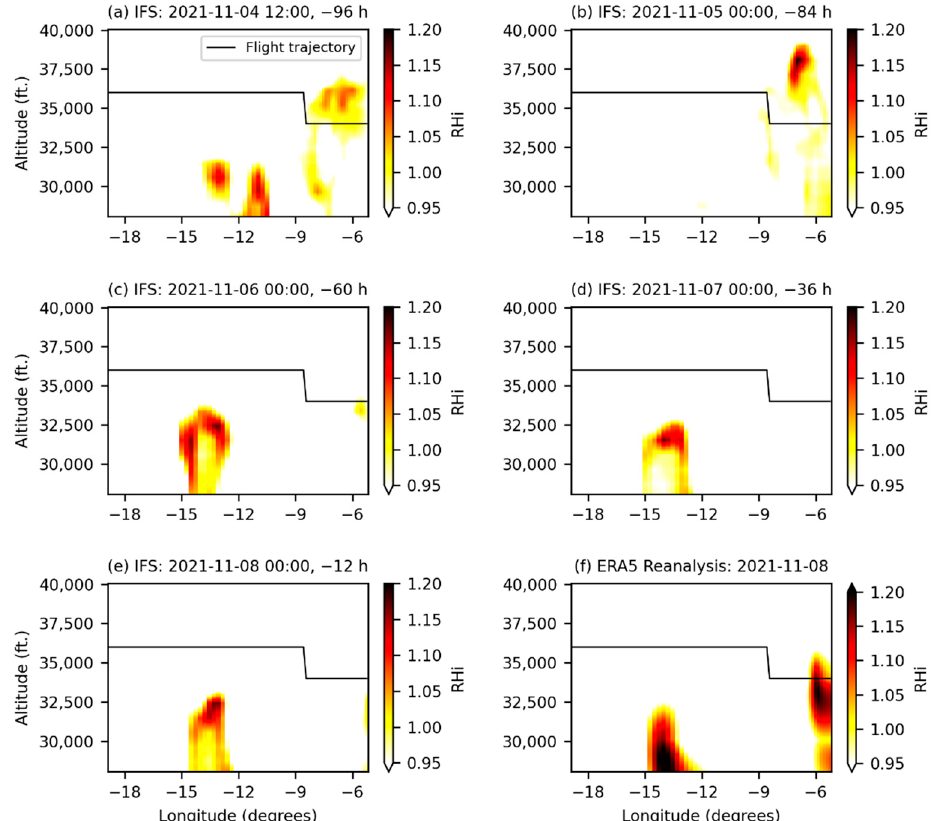
Figure 2. Evolution of ISSR forecasts provided by the European Centre for Medium-range Weather Forecast (ECMWF) Integrated Forecast System between T-96 h (panel a) and T-12 h (panel e), and the actual ISSR encountered during a flight (panel f) provided by the European Centre for Medium-range Weather Forecast (ECMWF) ERA5 High-Resolution Realization